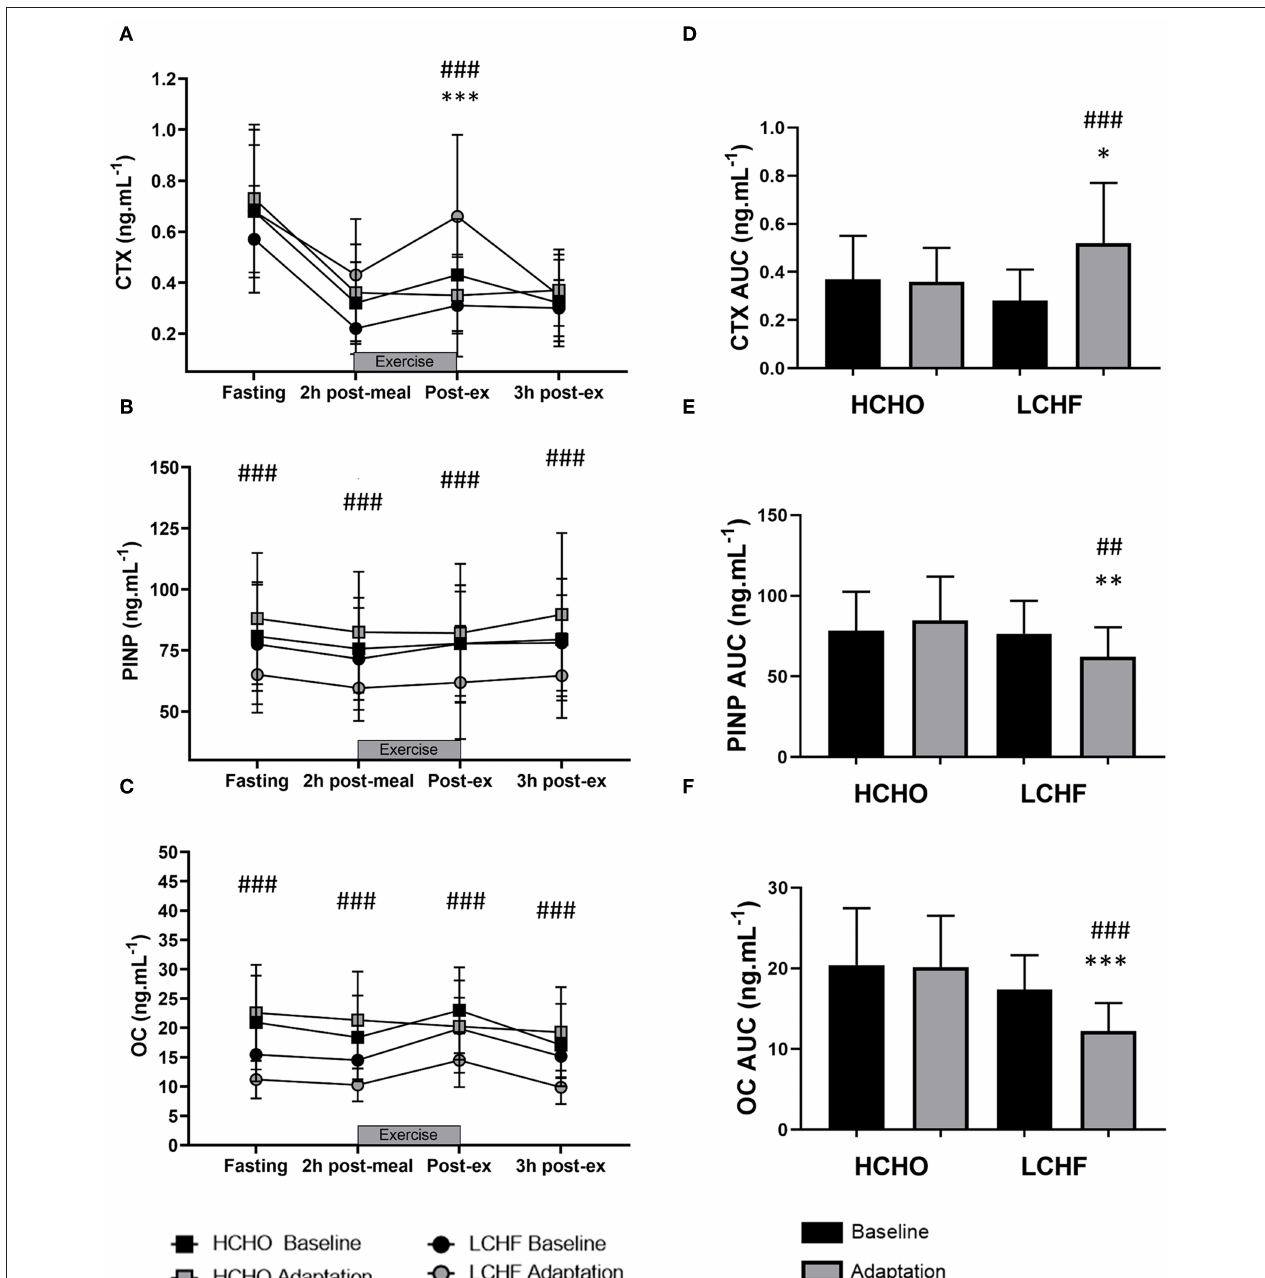
FIGURE 3 | Time course of changes in bone marker concentrations across exercise (left panel) and exercise area under curve (right panel) for serum C-terminal telopeptide of type I collagen (CTX) (A,D) , procollagen 1 N-terminal propeptide (P1NP) (B,E) , and osteocalcin (OC) (C,F) after the 3.5-week dietary intervention. Black bars/symbols represent Baseline, gray bars/symbols represent Adaptation. Squares and circles represent high carbohydrate (HCHO) and low carbohydrate high fat (LCHF), respectively. Gray bars represent a hybrid laboratory/field 19–25km walk test at ∼ 75% VO 2 max. Data are means ± standard deviations. ## p < 0.01; ### p < 0.001 denotes significant differences at time points or tests within diet groups. * p < 0.05; ** p < 0.01; *** p < 0.001 denotes significant differences between diet groups at a specific time point.